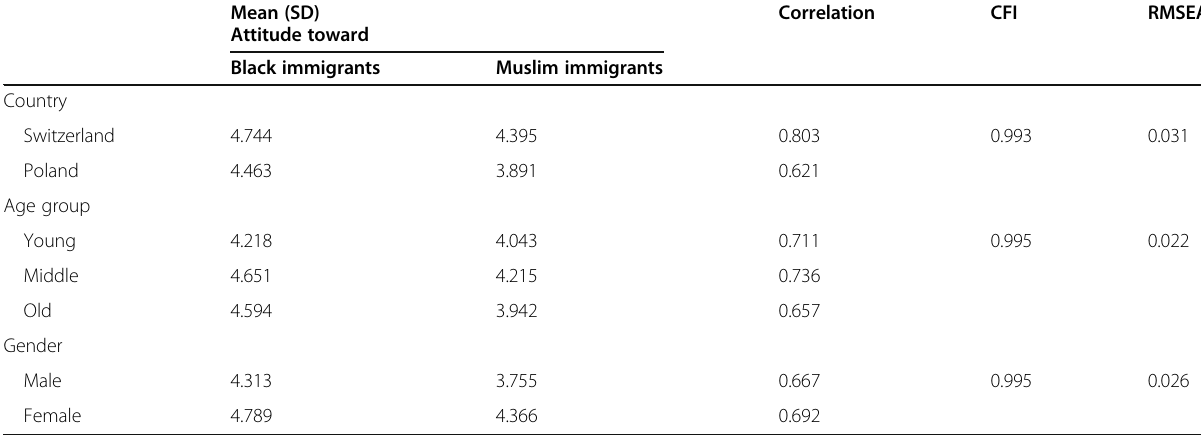
Table 8 Group differences in the attitude means across country, age, and